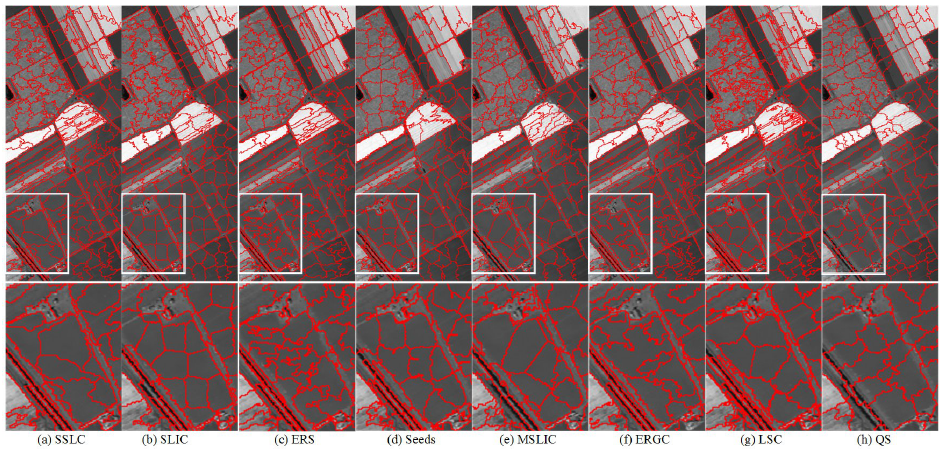
Figure 15. The first row is superpixel segmentations of AVIRIS image Salinas provided by ( a ) SSLC; ( b ) SLIC; ( c ) ERS; ( d ) Seeds; ( e ) MSLC; ( f ) ERGC; ( g ) LSC; and ( h ) QS. The second row zooms in on the regions of interest as defined by the white boxes to facilitate close visual